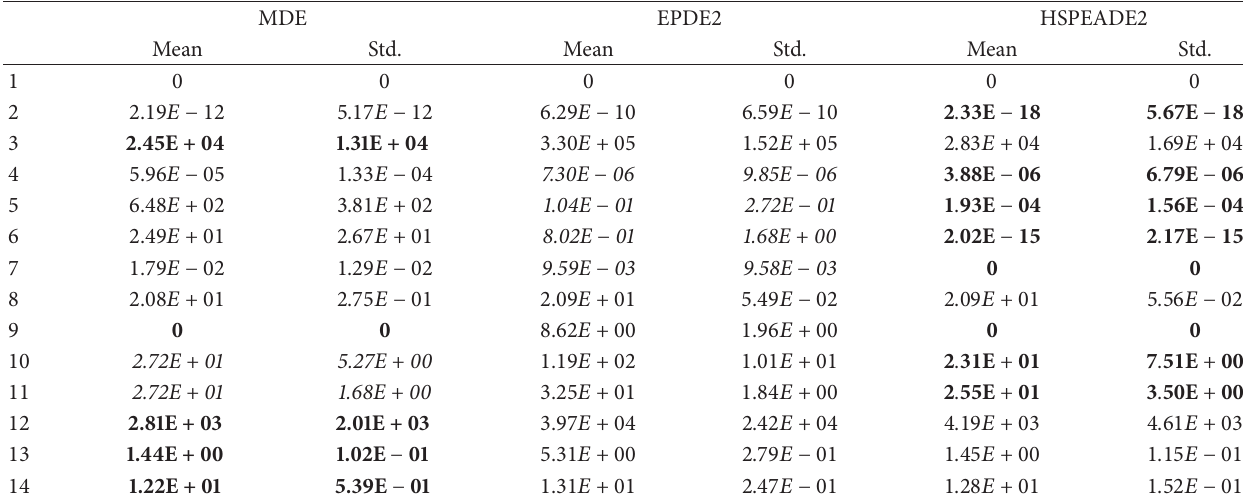
Table 4: Performance of MDE, EPDE2, and HSEPDE2 on 30D